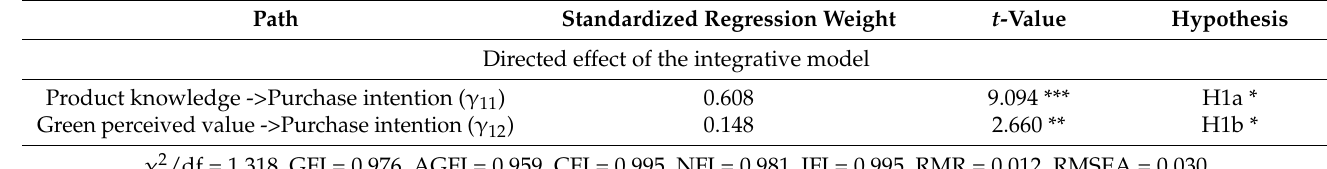
Figure 2. Results of the hypothesized model. Note. ** p < 0.01; *** p < 0.001. Table 4. The model’s standardized regression weights, t -values, and